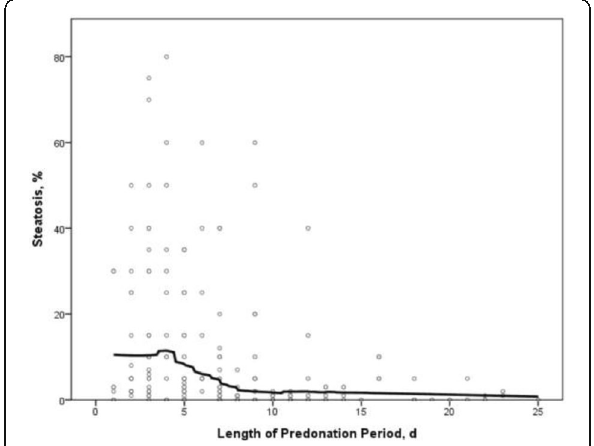
Fig. 1 (abstract 0043). Distribution of steatosis according to the length of predonation